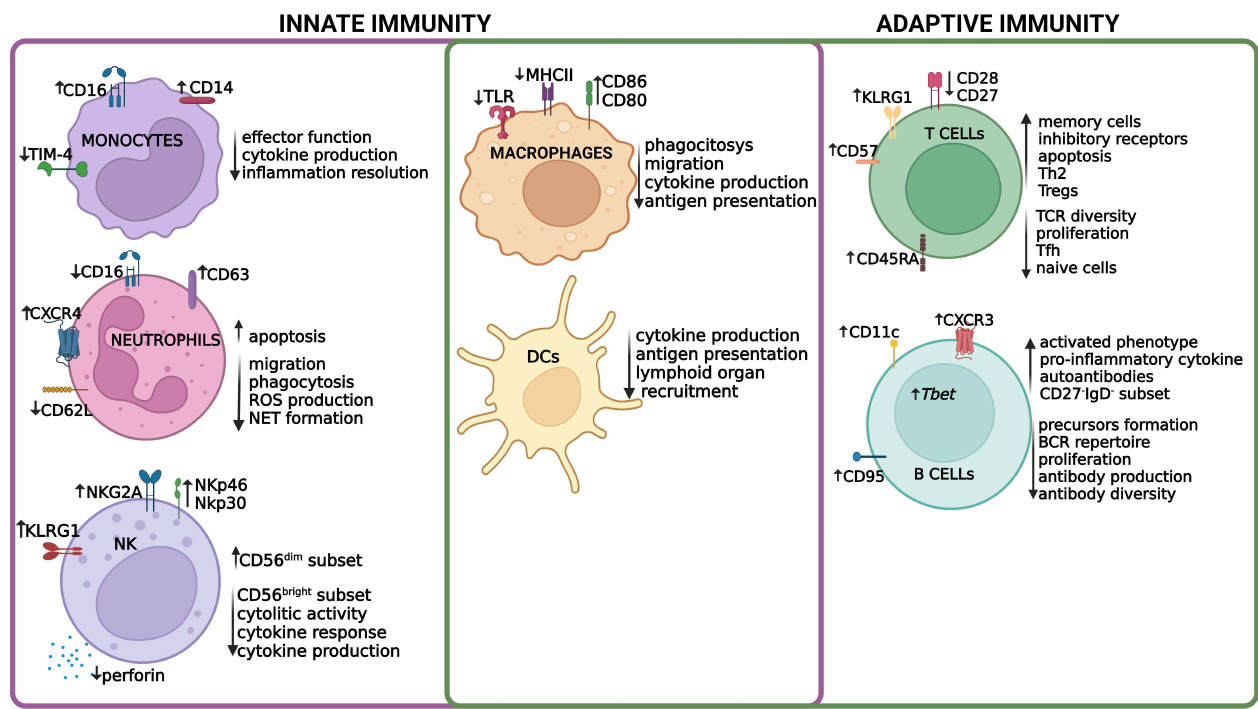
Figure 1. Simplified picture of phenotypical and functional modifications occurring in innate and adaptive immune cell populations during